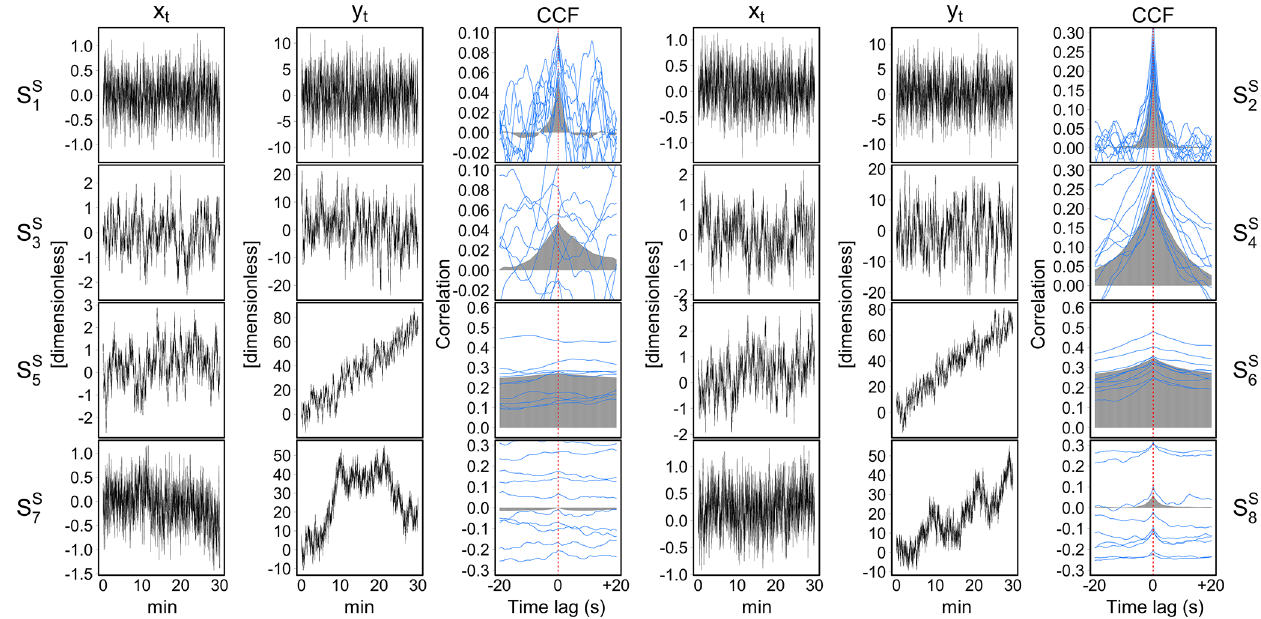
Figure 8. Illustrative examples of simulated AR processes, x t and y t , and their cross-correlation function (CCF) in each of the eight scenarios, S S , described in Sect. 3.1.3 and designed to evaluate the performance of the stationarity tests. Grey areas represent the ensemble CCF i = 1 ,..., 8 averaged over multiple simulation runs. Blue lines represent the CCF estimated in 10 individual simulation